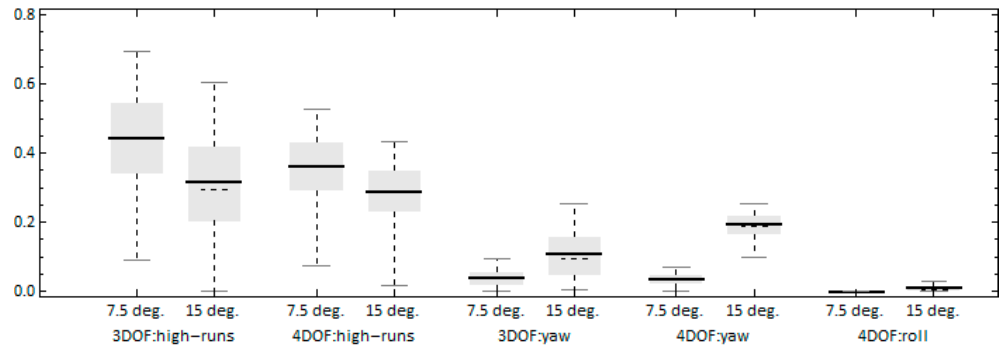
Figure 9. Effect of the commanded heading on the time-ratio of high-runs, yaw and roll angle exceedances. For the 4DOF model, KG = 6.5 m.